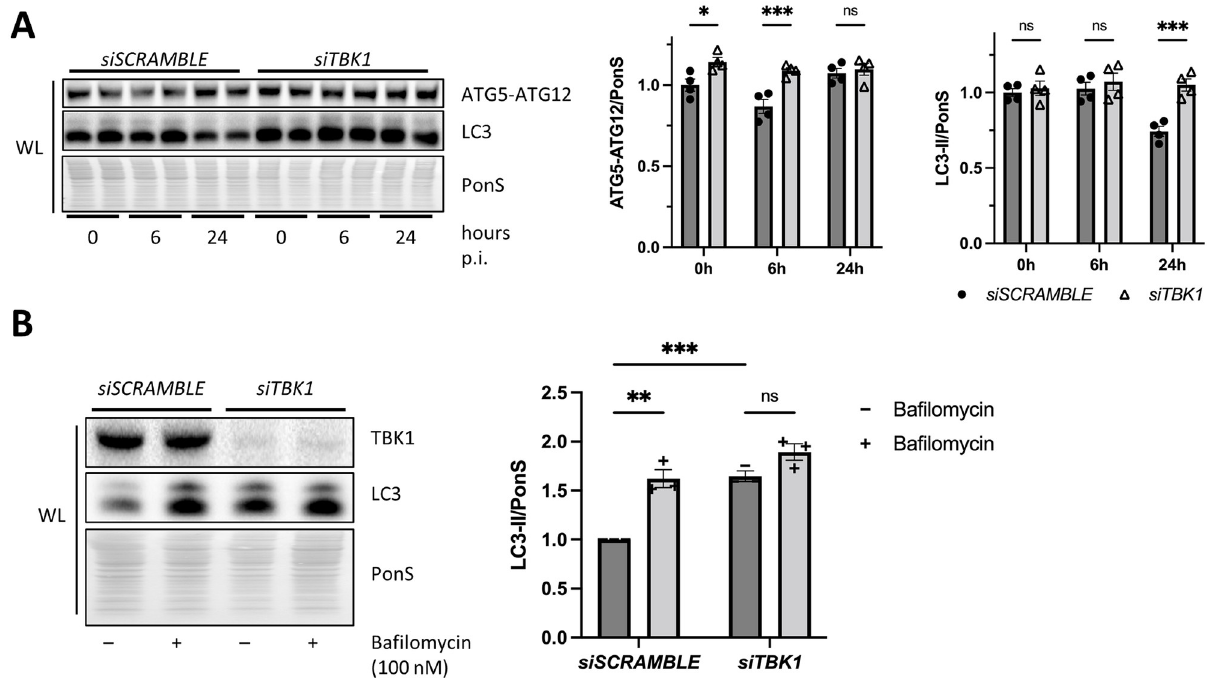
Fig 3. Silencing TBK1 impairs autophagic flux. HeLa cells were treated with siRNA targeting TBK1 ( siTBK1 ) or scrambled RNA ( siSCRAMBLE ). (A) Western blot of infected cells at 0 h, 6 h, and 24 h p.i. at MOI 0.01. Densitometric quantification of Western blots. � , p < 0.05, ��� , p < 0.001, two-way ANOVA; n = 4. (B) Western blot of cells treated with vehicle or bafilomycin (100 nM) for 2 h. Densitometric quantification of Western blots. �� , p < 0.01, ��� , p < 0.001, two-way ANOVA; n = 3. Data are representative of 3 experiments. WL = whole